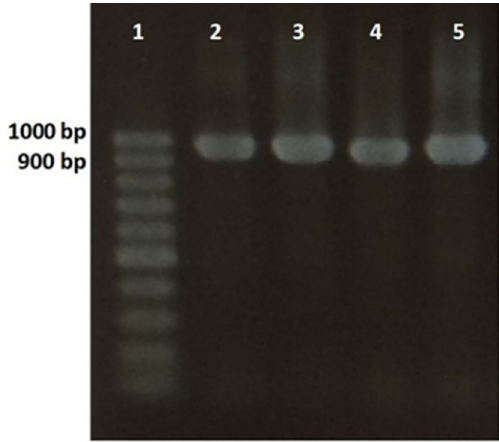
Figure 1. Agarose gel electrophoresis of internal transcribed spacer (ITS) PCR products from four Steinernema feltiae isolates: Lane 1: 100 bp DNA Ladder; Lane 2: PCR product of control sample ( S. feltiae from biopreparation); Lane 3: PCR product of iso1Lon; Lane 4: PCR product of iso1Dan; Lane 5: PCR product of iso1Obl.